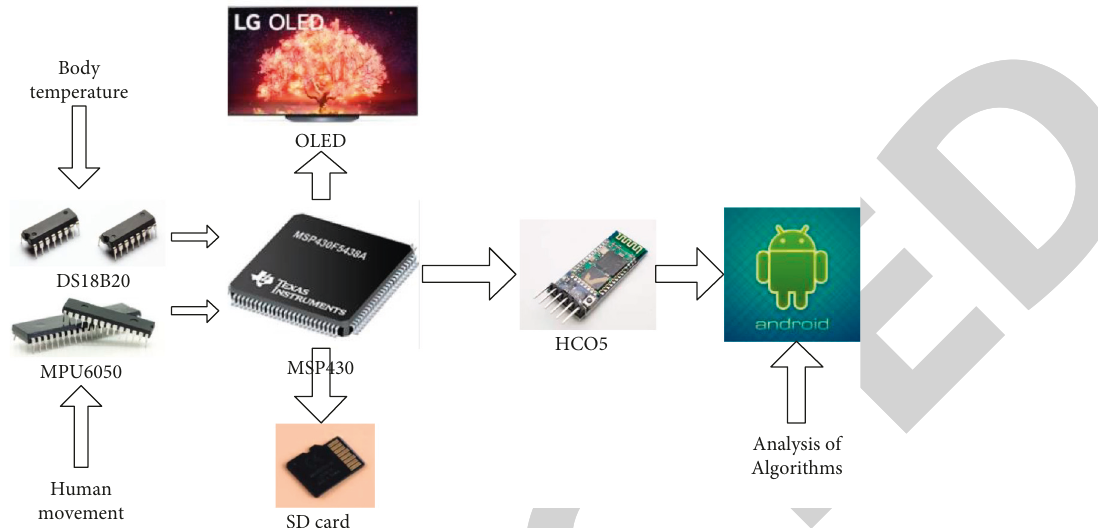
Figure 6: System framework and information